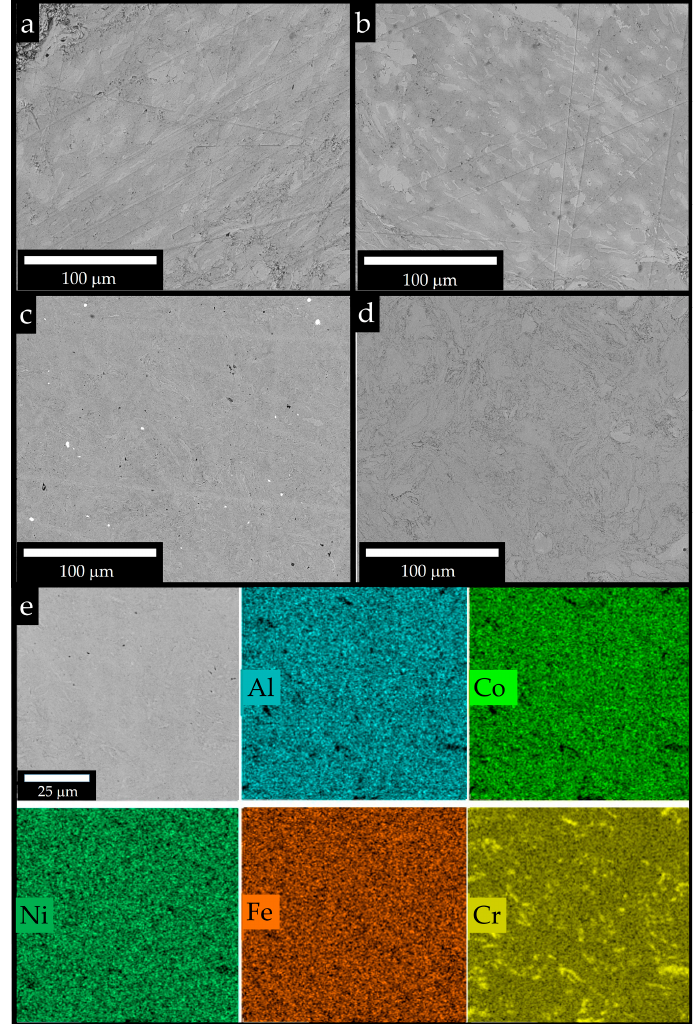
Figure 6. Microstructure of the samples sintered by RSPS at 800 °C ( а ) and 1000 °C ( c ), and CS+SPS at 800 °C ( b ) and 1000 °C ( d ), and EDS mapping RSPS at 1000 °C ( e ).